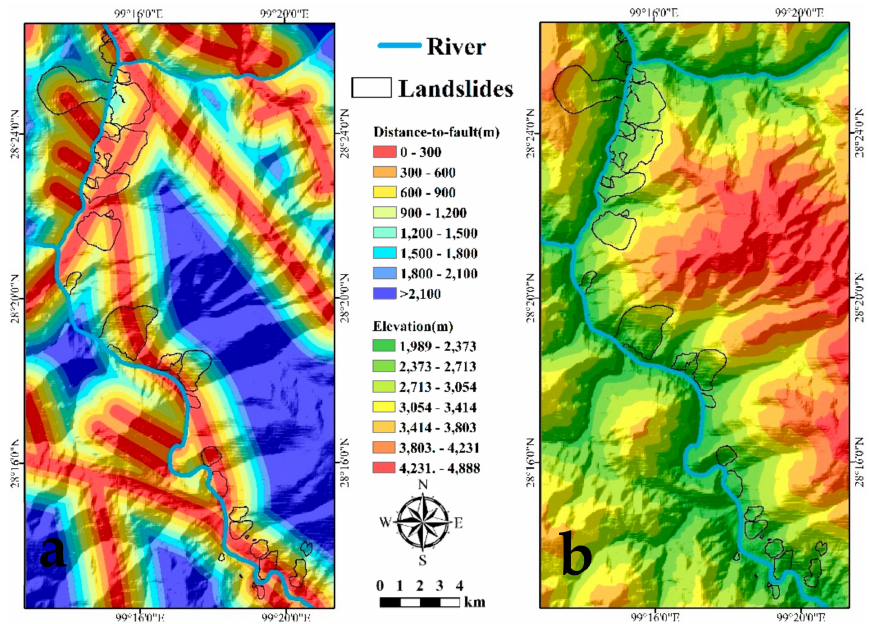
Figure 7. Influencing factors maps of the study area: ( a ) distance-to-fault and ( b )